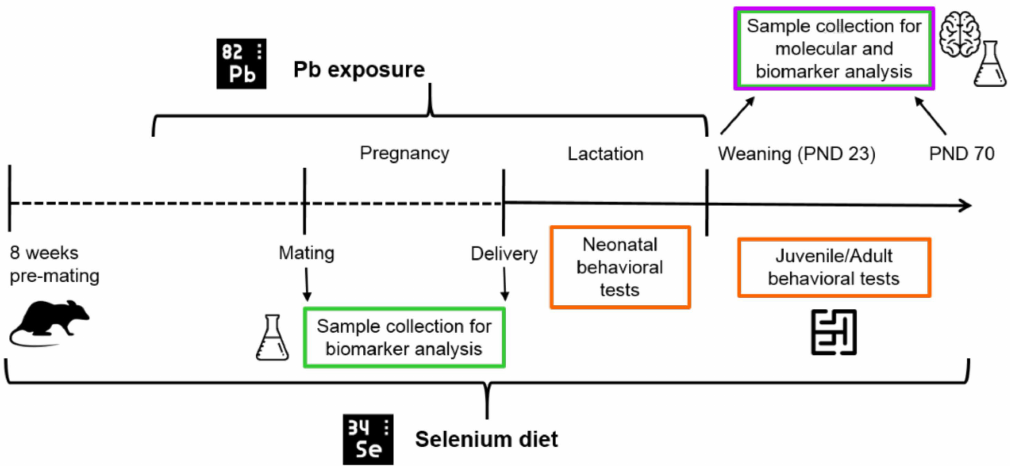
Figure 1. Timeline of experimental design. Female rats were fed an optimal (0.15 mg/kg) or suboptimal (0.04 mg/kg) Se diet for 8 weeks pre-mating, and, after 4 weeks, they were exposed until the end of lactation to 12.5 µ g/ µ L Pb via drinking water. At weaning (post-natal day, PND 23), offspring were fed on the same diet as their respective dams until adulthood and completion of the behavioral assessment. Behavioral testing (neonatal and juvenile/adult tests) and tissue collection for Se and Pb determinations and molecular analysis of hippocampus were performed at the time points